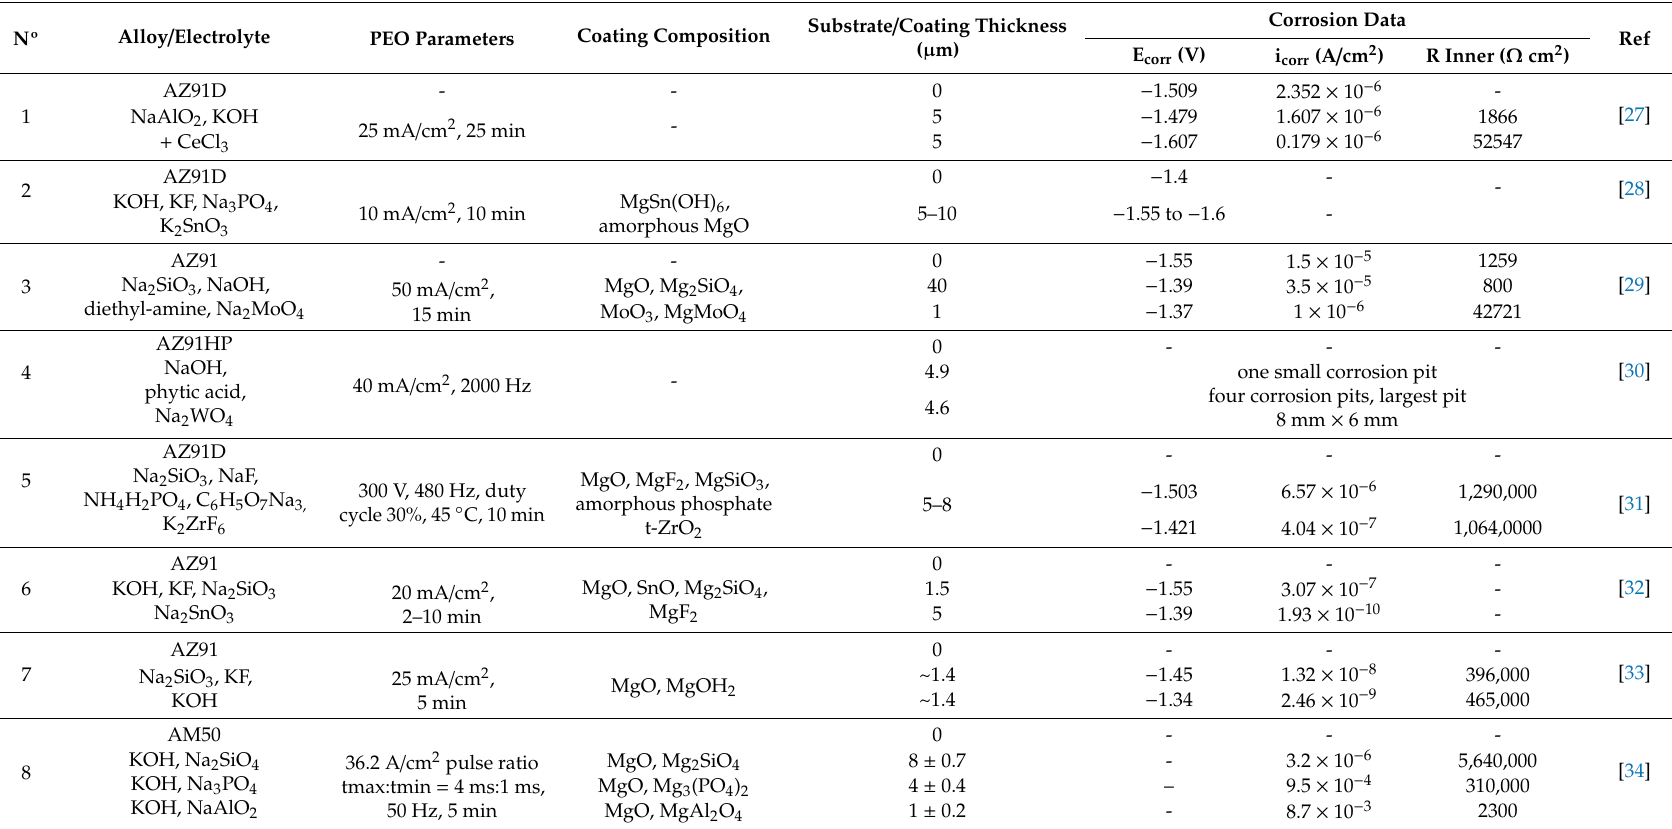
Table 2. Summary of the conditions and the properties of thin PEO coatings on Mg